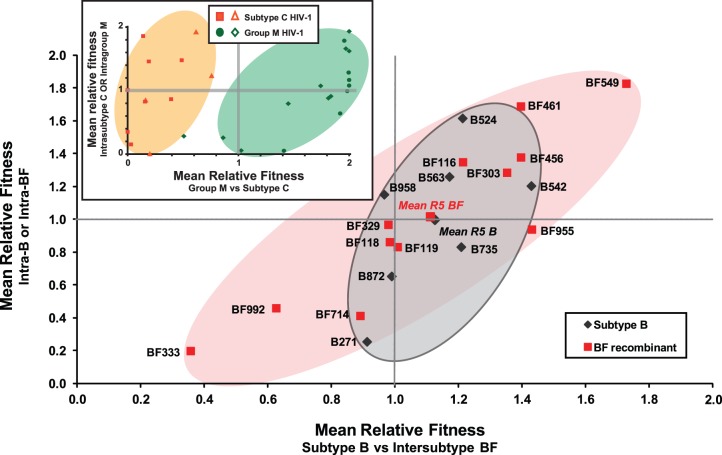
Comparison of intra- and intersubtype fitness of R5 HIV-1 subtype B and various BF recombinants from Argentina.Mean relative fitness values were determined for each HIV-1 isolate from pairwise competitions between isolates of the same subtype (mean intrasubtype relative fitness) and of different subtypes (mean intersubtype relative fitness). The mean intrasubtype and intersubtype fitness values for each HIV-1 isolate were then plotted as the x and y coordinates. Subtype B viruses are shown as black filled squares while BF recombinants are indicated by a red filled square. The mean fitness of subtype B and BF are very similar and also indicated as red and black filled squares respectively. The insert figure represents the fitness of HIV-1 subtype C relative to group M strains as described in a previous study (Abraha et al, 2009). Subtype C strains (red squares and triangles) have low mean relative fitness and cluster together (orange oval shade) while group M strains (green dots and tetragon) are more fit and cluster together as well (green oval shade).